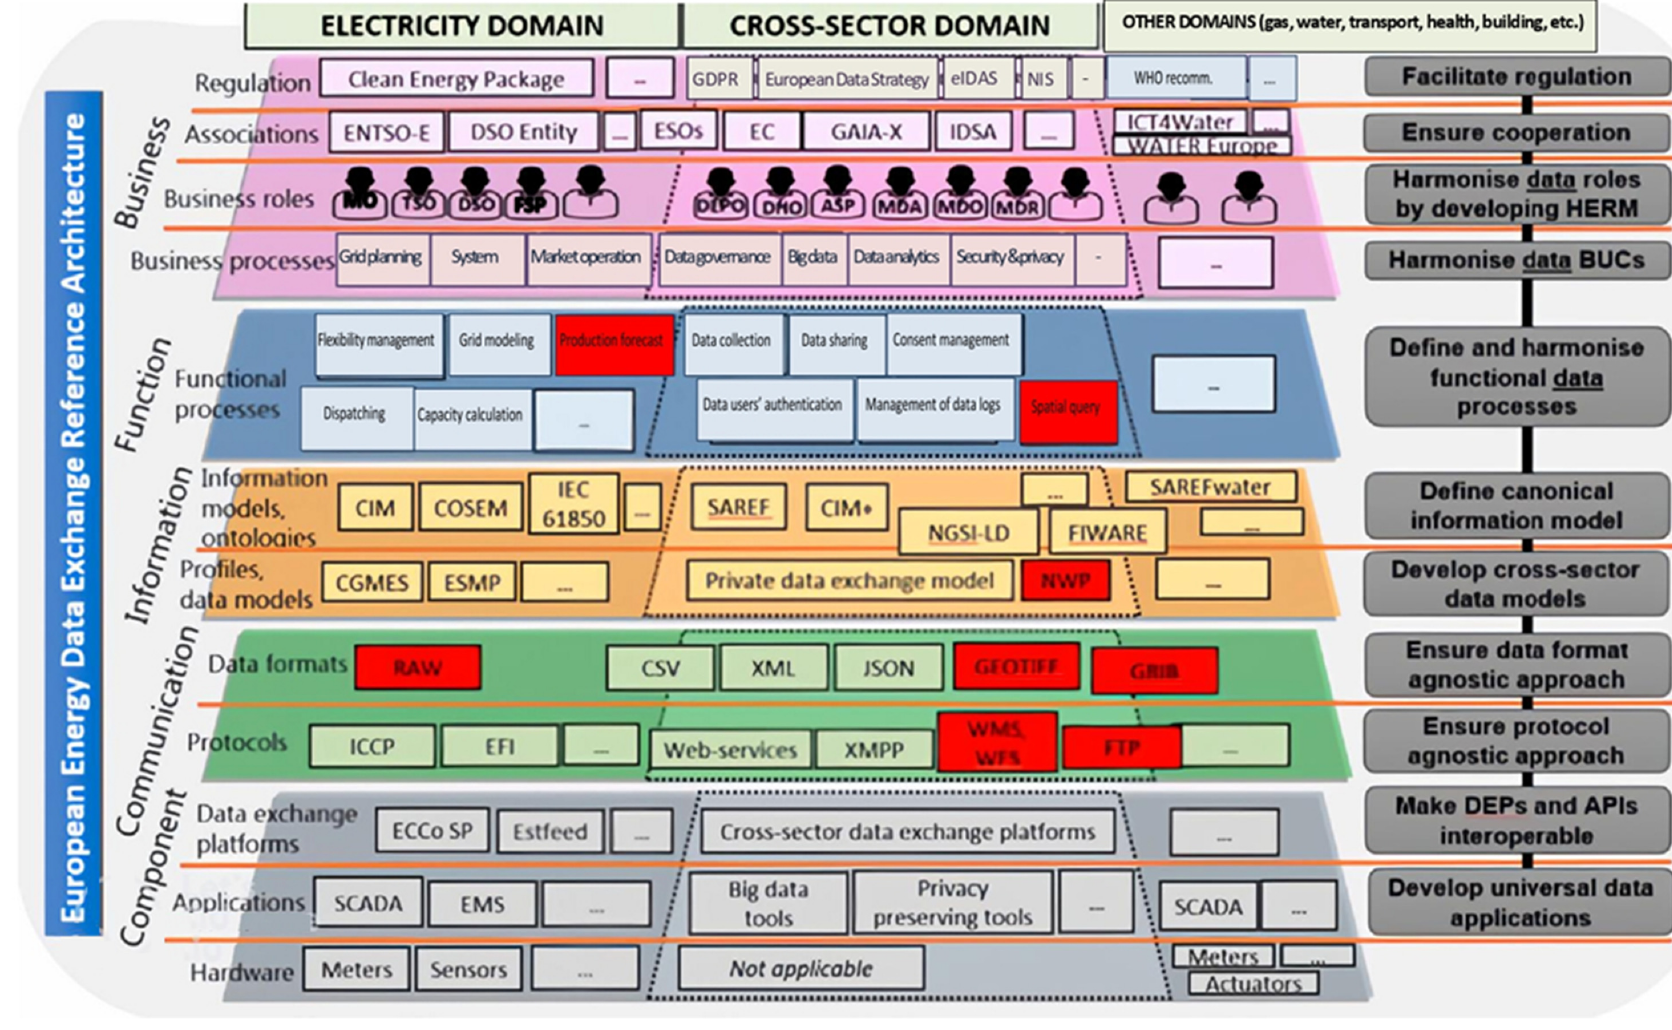
Figure 9. European energy data exchange reference architecture [40].